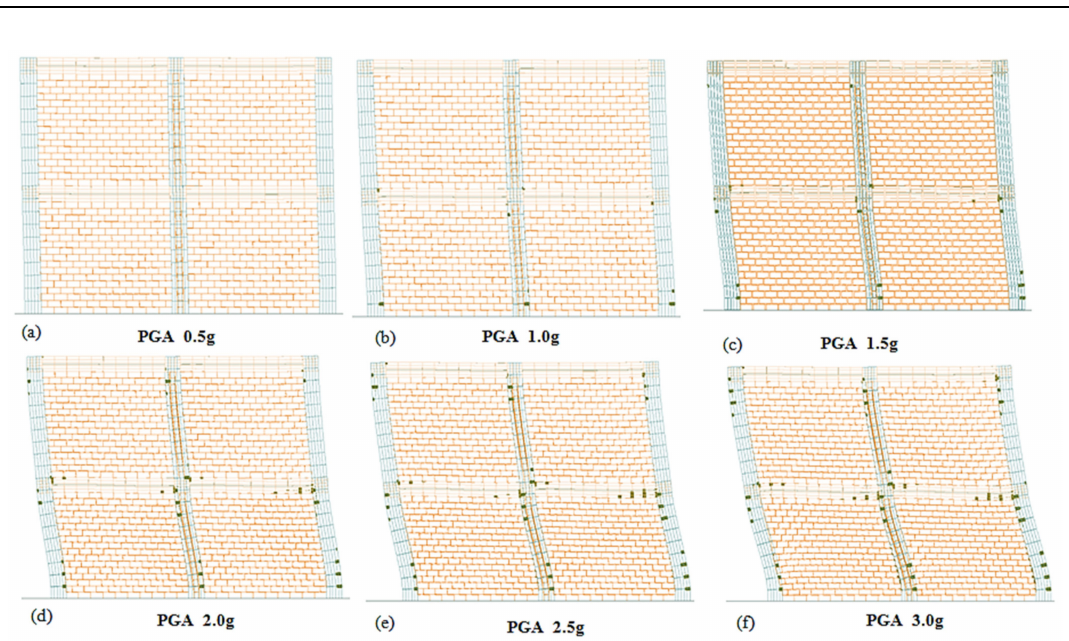
Figure 22. Damage Profiles of AEM models for H-building structure (RC and IFM) at PGA: ( a ) 0.5 g; ( b ) 1.0 g; ( c ) 1.5 g; ( d ) 2.0 g; ( e ) 2.5 g; ( f ) 3.0